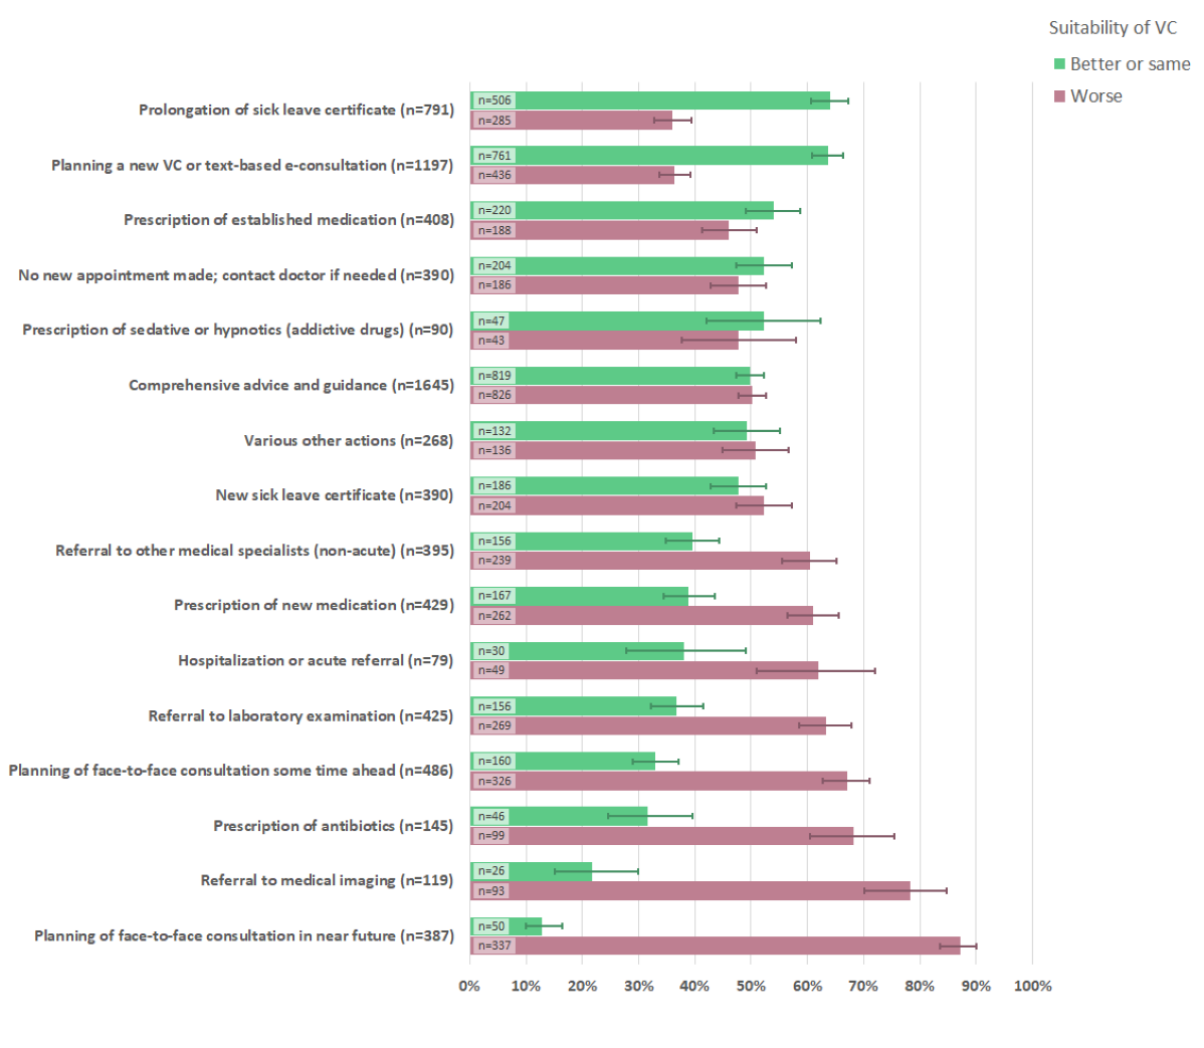
Figure 4. Associations between general practitioners' perceived suitability of video consultations and actions taken during/after the consultation. The actions taken are sorted by general practitioners' perceived suitability (better or same) of the video consultation in question, displayed in decreasing order. 95% CIs are illustrated by lines. VC: video